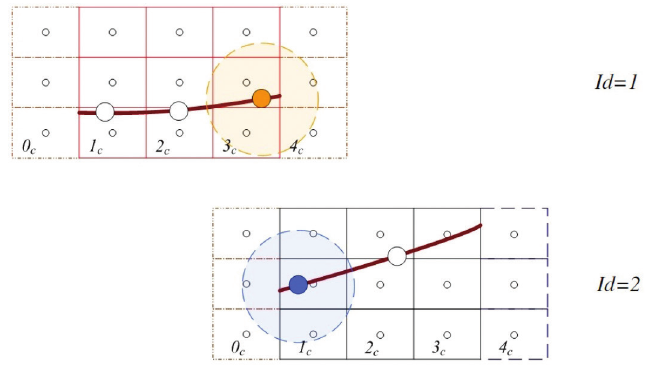
Figure 3 - Correct distribution of Lagrangian forces in a parallel approach. Step 1.